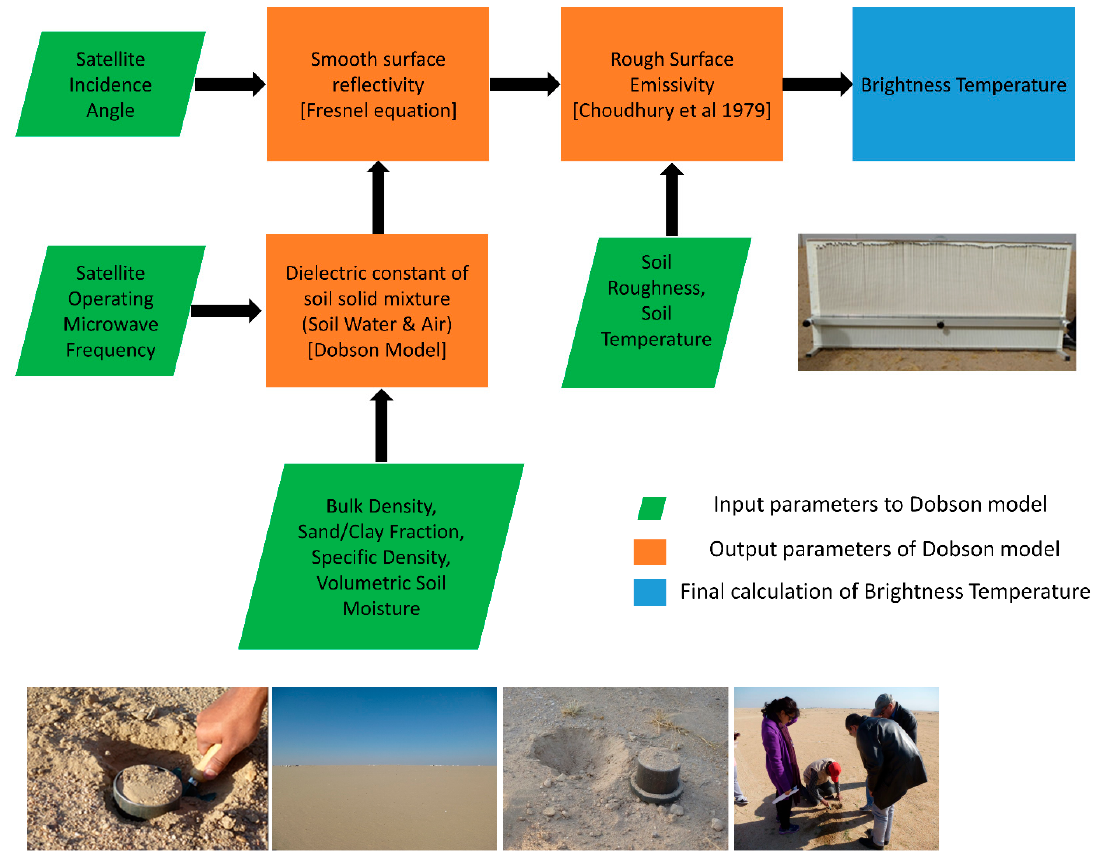
Figure 2. A schematic diagram showing the simulation of the brightness temperature.